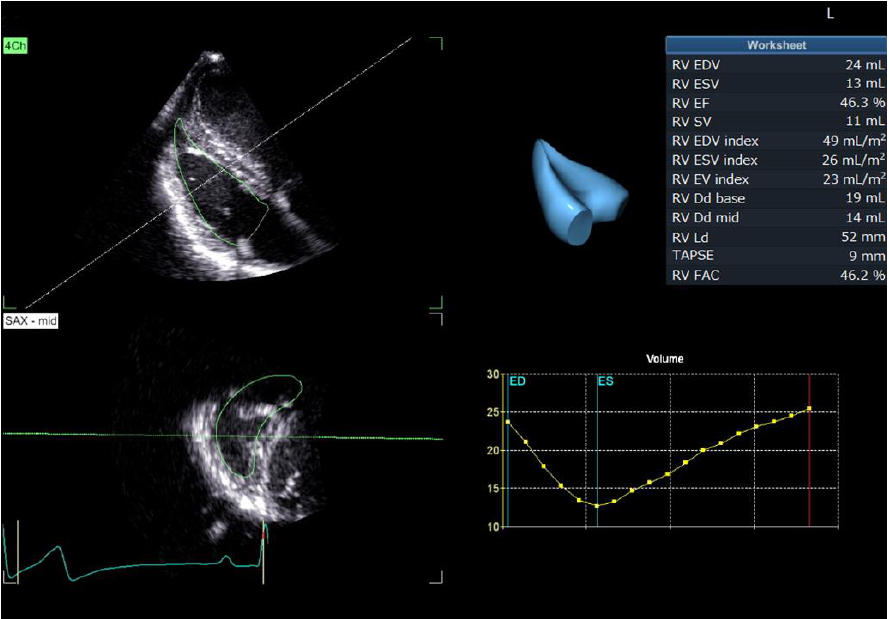
Figure 1. A representative image of the right ventricular volume generated by the 4D Auto RVQ software (GE Healthcare, Tokyo, Japan). 4Ch: left apical four-chamber view optimized for the right heart; ED: end-diastole; ES: end-systole; RV: right ventricular; RVEDV: end-diastolic RV volume; RV EF: RV ejection fraction; RVESV: end-systolic RV volume; RV FAC: RV fractional area change; RV SV: RV stroke volume; SAX–mid: short axis view of the middle right ventricle; TAPSE: tricuspid annular plane systolic excursion. Green circle represents the automatically traced right ventricular endocardial